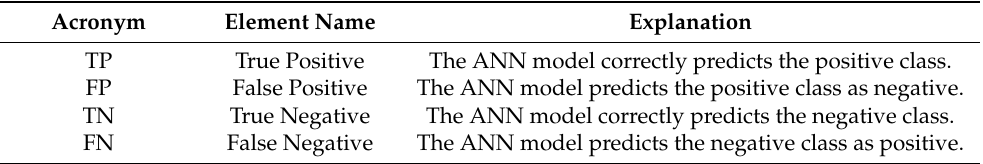
Table 5. Element of ANN evaluation